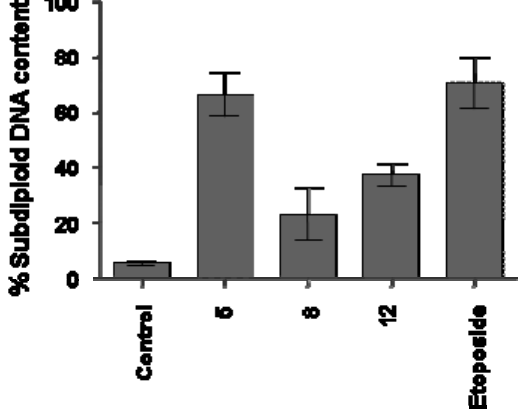
Figure 3. Flow cytometry analyses of DNA content of Jurkat cells treated with synthetic compounds 5, 8 and 12 for 18h. Cells were analyzed with the FACScan flow cytometer as described in the Experimental section.